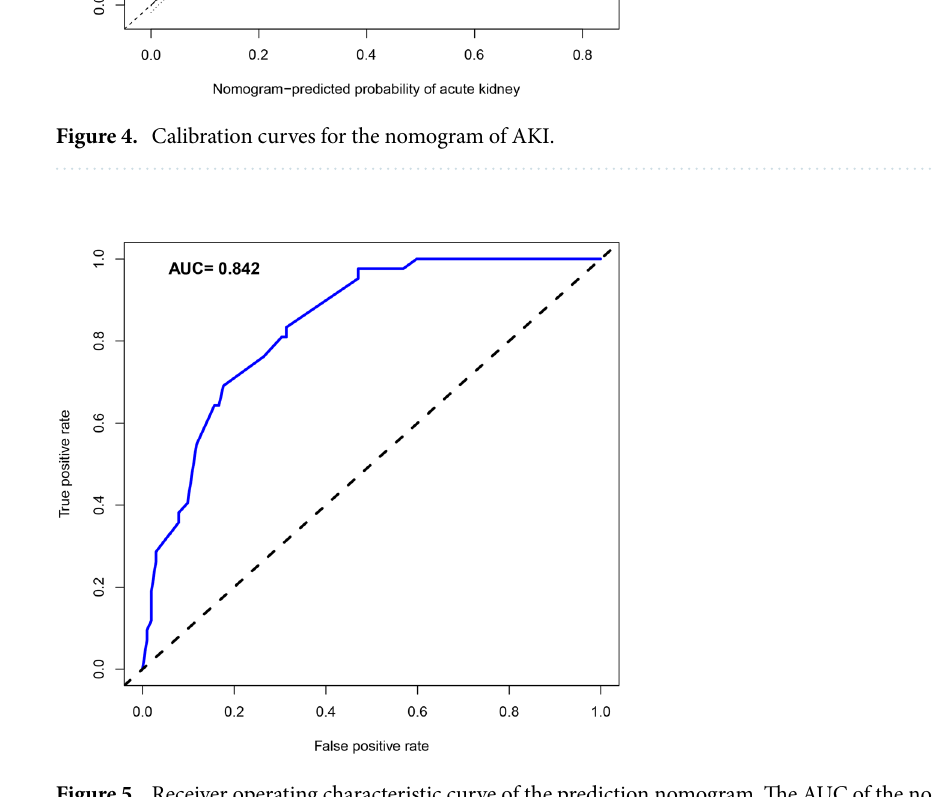
Figure 5. Receiver operating characteristic curve of the prediction nomogram. The AUC of the nomogram scoring system for predicting AKI was